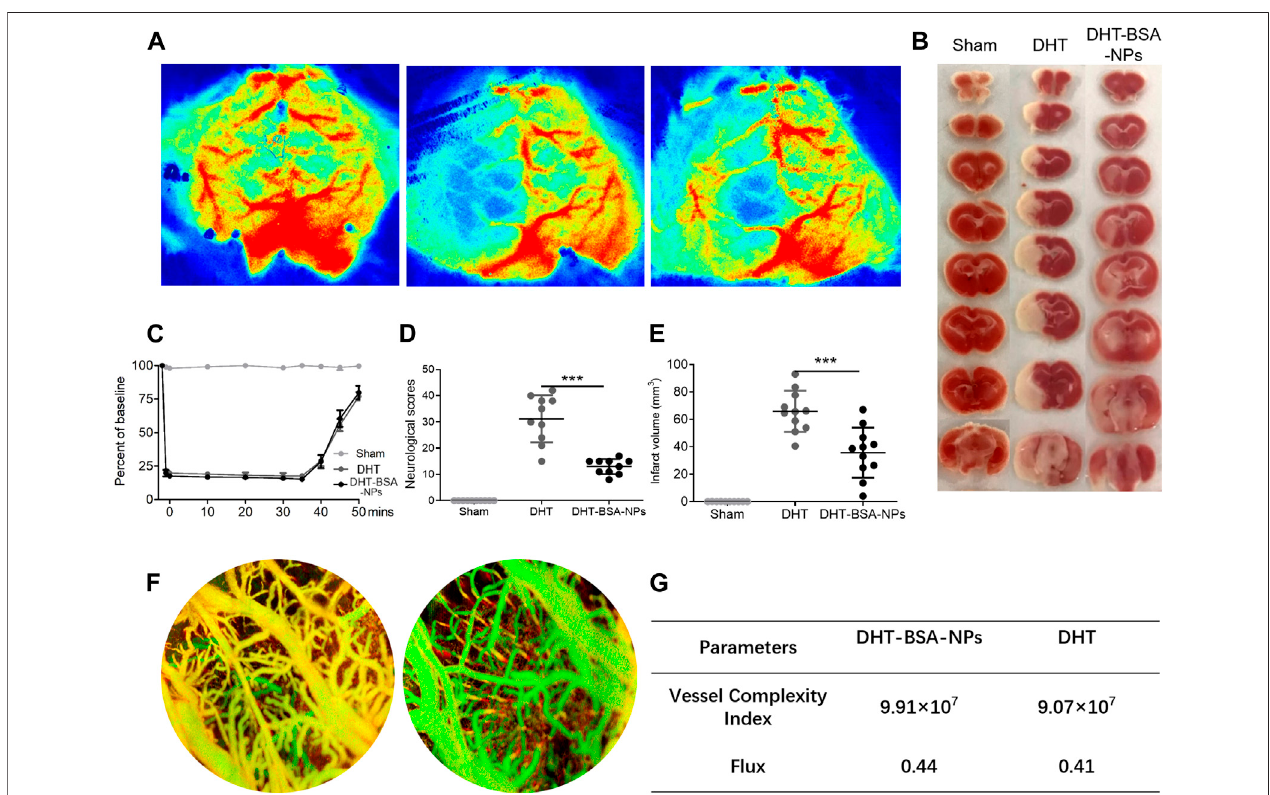
FIGURE 4 | DHT – BSA NPs treatment improved the CBF of the ischemic cortex and reduced the area of cerebral infarction. (A) The representative pseudocolor image of CBF in the ischemic cortex after MCAO/R (left: sham; middle: DHT; right: DHT – BSA NPs). (B) The representative images of TTC-stained section. (C) Quanti fi cation of the relative CBF in the ROI (% of baseline for each animal). (D) MCAO/R caused signi fi cant neurological de fi cits. Compared with the DHT group, the DHT – BSANPsgroupreducedtheneurologicalscoreafterMCAO/R.Incontrast,ratsintheshamoperationgrouphadnoneurologicalde fi cits. (E) Quanti fi cationof the infarct volume showed that compared with the DHT group, the DHT – BSA NPs group signi fi cantly reduced the infarct volume after MCAO/R. (F) The OCT image of the brain tissue with DHT – BSA NPs and DHT. (G) OCT detects blood vessel indicators. The data represent the mean ± SD ( n (cid:1) 10 in each group). *** p < 0.05.